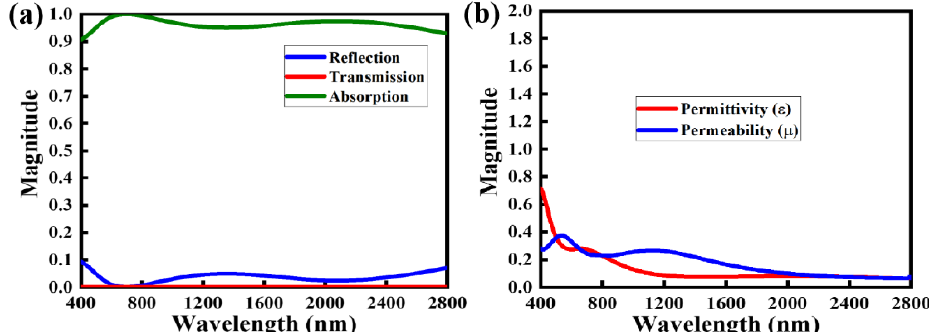
Figure 2. Optical characteristics of the proposed NMMA: ( a ) scattering parameters of the proposed NMMA, solid green line denotes the absorption curve, whereas red and blue solid lines represent the transmission and reflection parameters of the proposed NMMA, respectively, and ( b ) absolute value of the permittivity and permeability of the proposed NMMA.